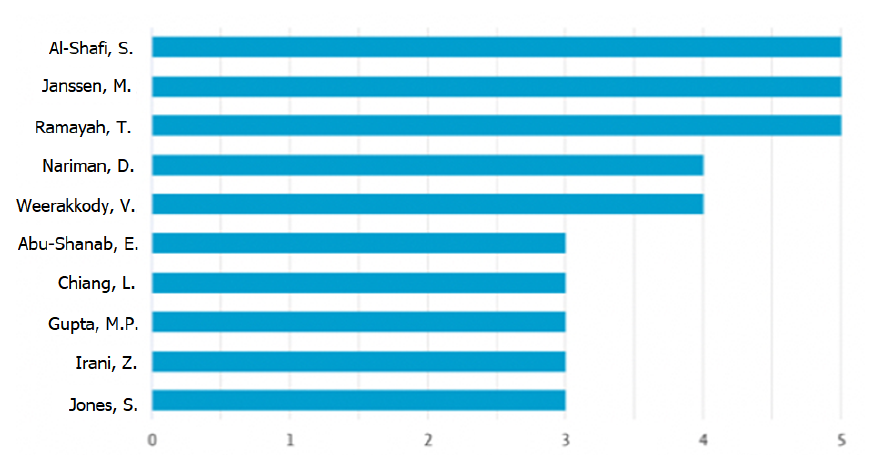
Figure 2. Top ten authors with the highest number of documents retrieved.